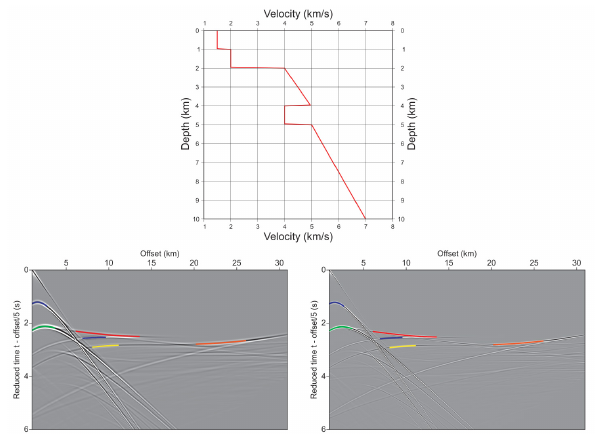
Fig. 11. 1-D model used to generate synthetic data (top). Shots generated using the model and different frequencies: 10Hz (left) and 20Hz (right). Main phases were identified: sea bottom reflec- tion (blue), top basalt reflection (green), basalt refraction (red), base basalt reflection (purple), top basement reflection (yellow) and base- ment refraction (orange). Under the top of the basalt no phases were picked within the water-wave cone because in real data this phases are difficult to identify.